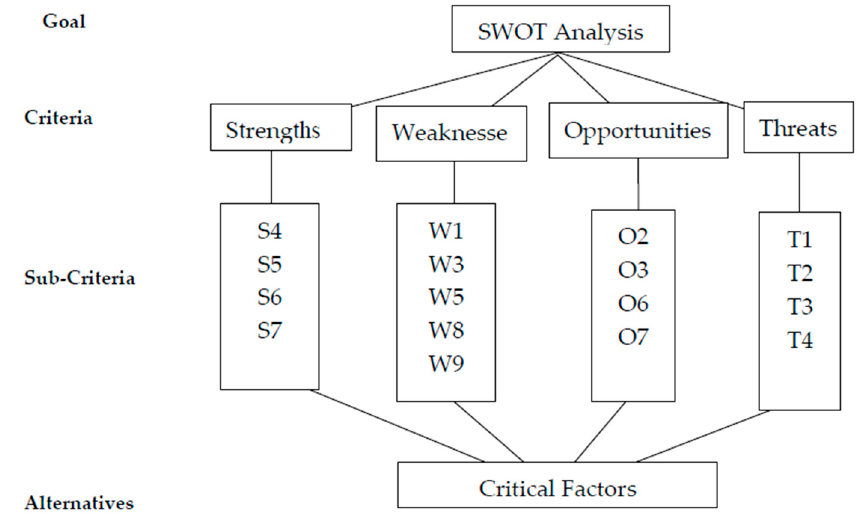
Figure 2. Hierarchy Model for SWOT Factors.